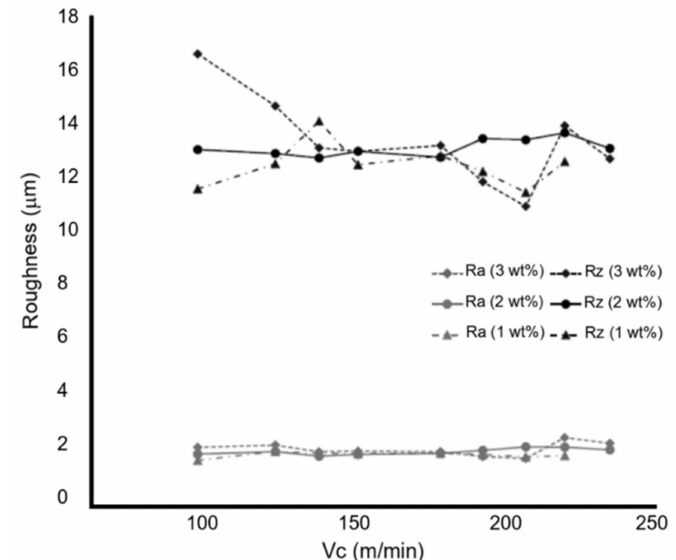
Figure 4. Evolution of roughness in relation with cutting speed for various percentages of